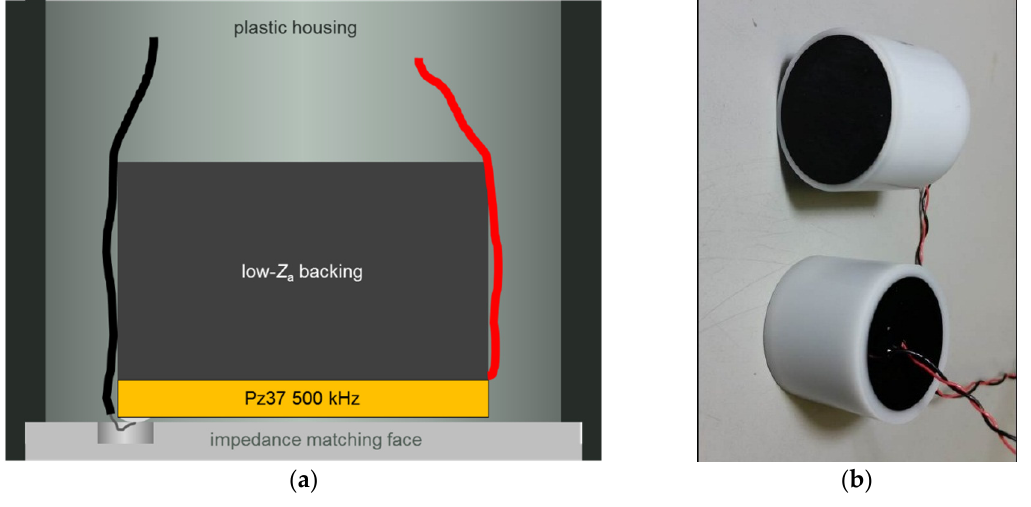
Figure 6. ( a ) Sketch of transducer design; ( b ) Photo of two assembled transducers.